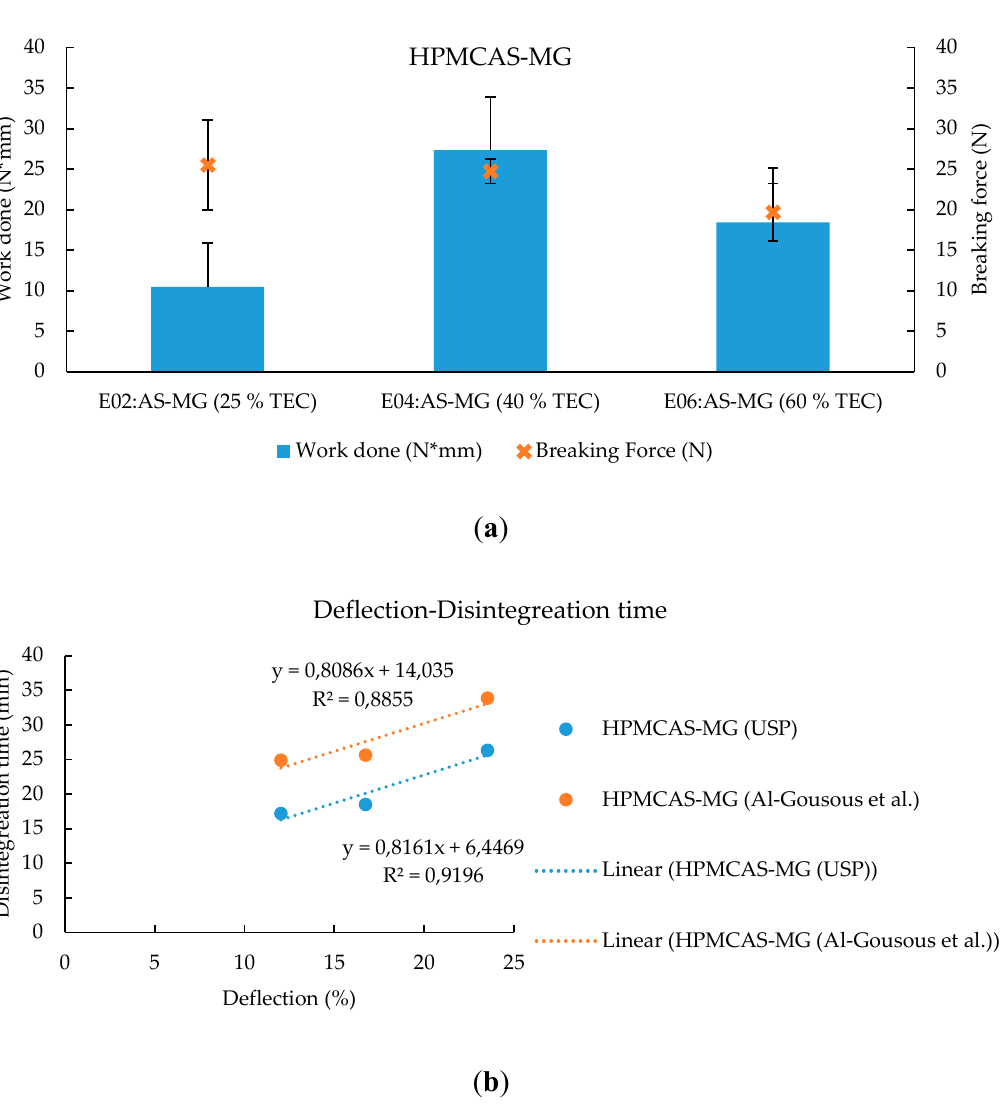
Figure 11. ( a ) Mechanical properties of capsules coated with HPMCAS-MG. Given are the average work done (N*mm) + SD and the breaking force (N) ± SD; n = 6. TEC content is based on dry polymer weight. ( b ) Correlation between disintegration time and deflection (% deflection calculated through dividing the observed deflection by the capsule diameter of 7.65 mm).